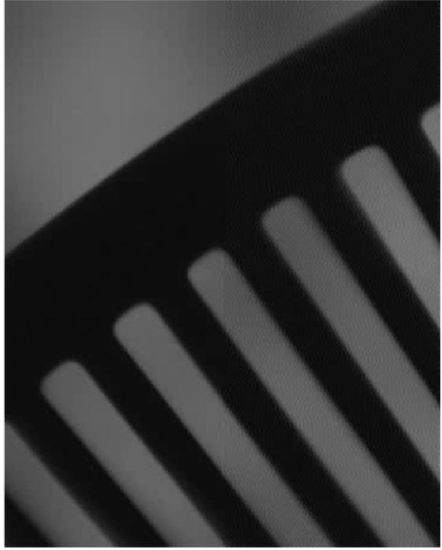
Figure 4. A laser chopper rotating at 6,000 rpm taken by the BSI ISIS at 16 Mfps